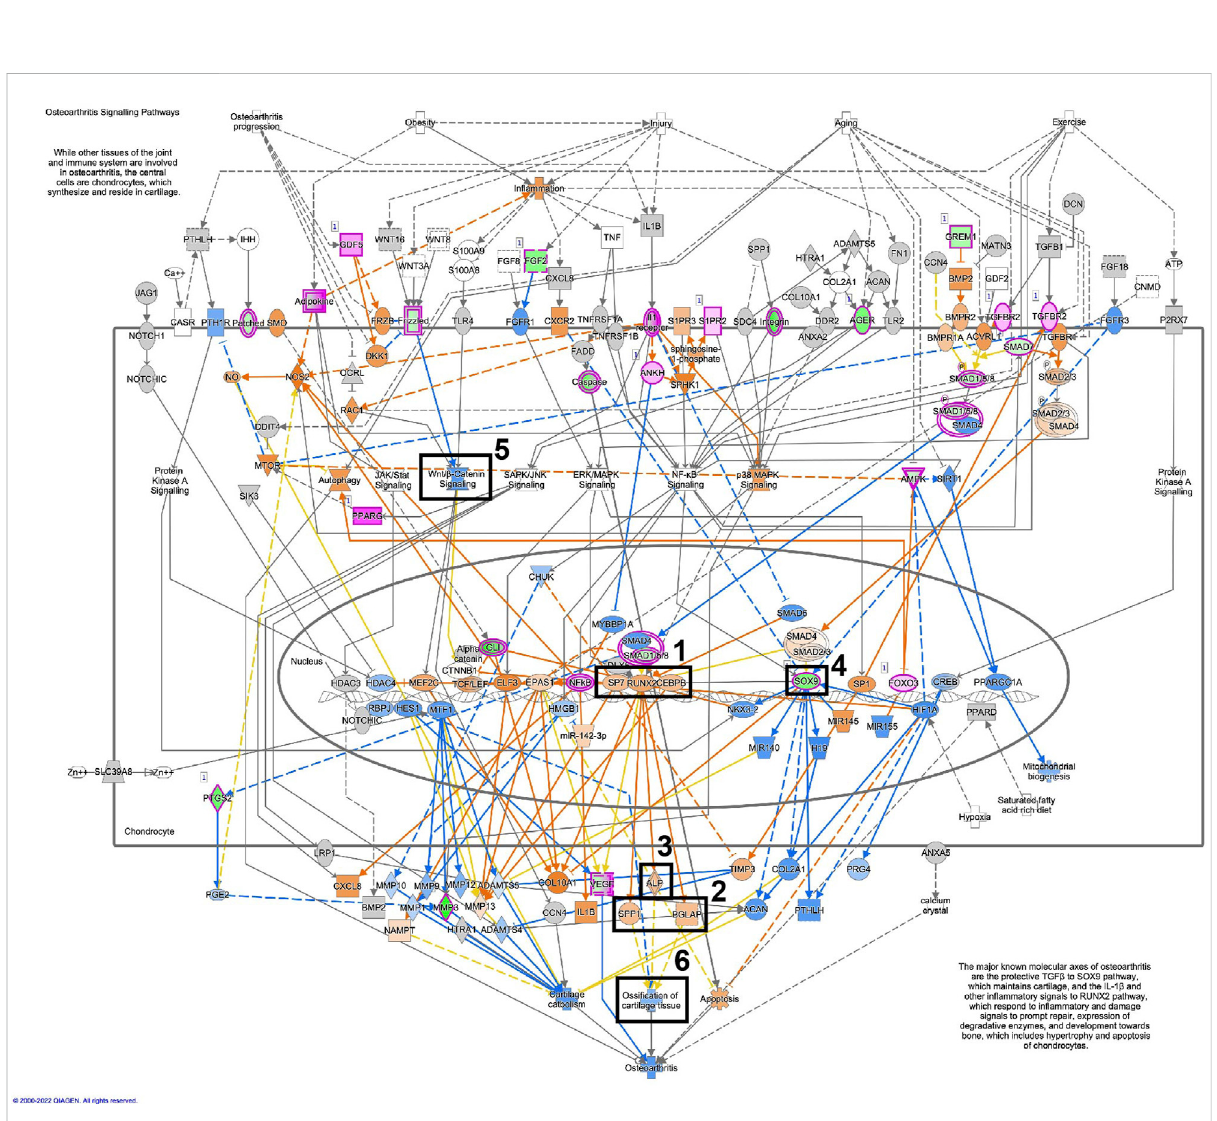
FIGURE 11 Osteoarthritis pathway is activated in osteoblastic differentiated fi broblasts. A detailed illustration of the osteoarthritis pathway in osteoblastic differentiated fi broblasts, based on the RNA-seq data. The most essential osteoblastic markers and processes have been highlighted in fi ve boxes (1 – 5). Box 1 (SP7, RUNX2, CEBPB), Box 2 (SPP1/osteopontin, BGLAP/osteocalcin), Box 3 (ALP/alkaline phosphatase), Box 4 (Sox9), Box 5 (Wnt/ β - catenin signaling), Box 6 (Ossi fi cation of cartilage tissue). For the pathway map, genes with an expression fold change of log2FC > abs (2) and p_adj. < 0.01 were selected from theRNA-seq data. Genes colored in pink are up-regulated, and genes colored ingreenare down-regulated. Genes colored in orange are predicted to be up-regulated, and genes colored in blue are predicted to be down-regulated, based on measured expression values from the